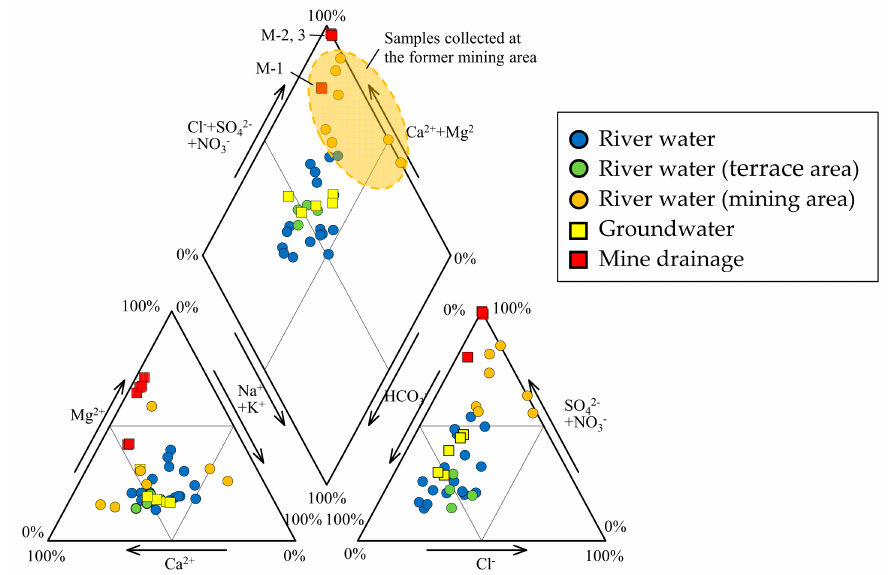
Figure 3. Piper diagram showing the hydrochemical facies of river water, groundwater, and mine